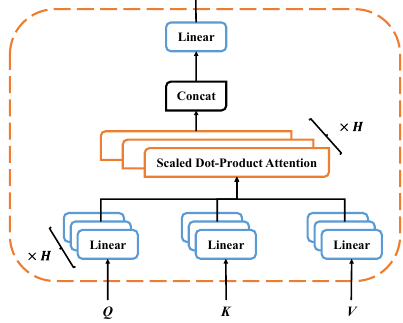
Figure 2. Multi-head attention of ViT.